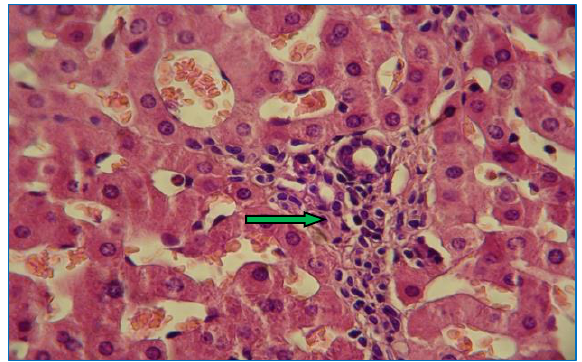
Figure, 10: G6: Liver of rabbits at 20 days post infection show slight infiltration of mononuclear cells in the portal areas ( ) (H and E 40x).